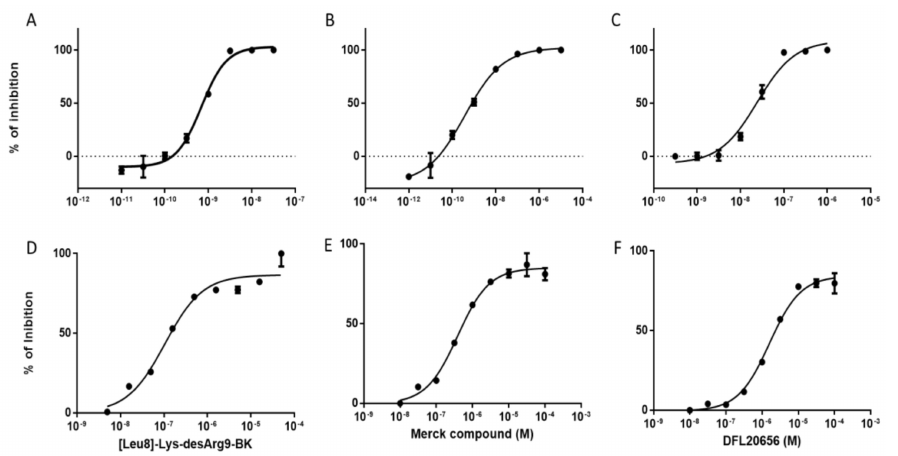
Figure 5. Selected compound activity in the intracellular calcium mobilization assay. Dose-response curves were generated to evaluate compound activity and to determine the IC 50 both in the transfectant CHO-B1 (up) and in the IMR90 human cell line (down) physiologically expressing the B1 receptor. The orthosteric peptidic inhibitor [Leu 8 ]-Lys-desArg 9 -BK ( A , D ), the Merck compound 14 ( B , E ) and Domp é DFL20656 ( C , F ) inhibited calcium release in CHO-B1 cells with pIC 50 of 9.16 ± 0.05, 9.42 ± 0.07 and 7.75 ± 0.16 respectively. The inhibition of Ca 2 + signaling was also observed in the IMR90 cell model with pIC 50 values of 7.0, 6.4 and 5.8 respectively. The data represent the mean ± SEM of six experimental